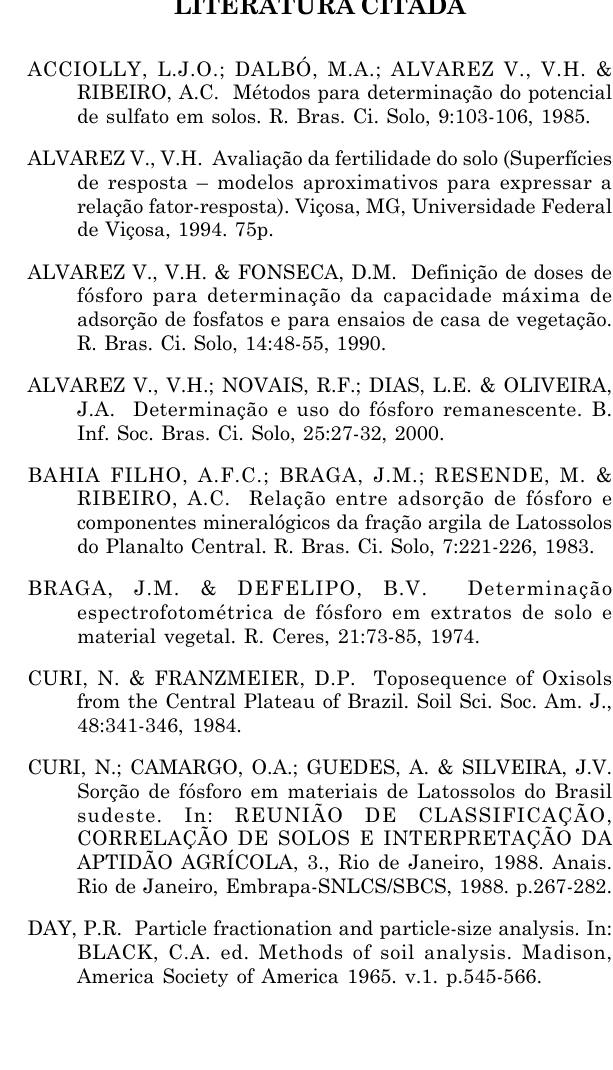
Quadro 4. Coeficientes de correlação linear entre fósforo remanescente (P-rem), capacidade máxima de adsorção de P (CMAP) e índice tampão de fosfato (ITP) e produção de grãos e acúmulo de P